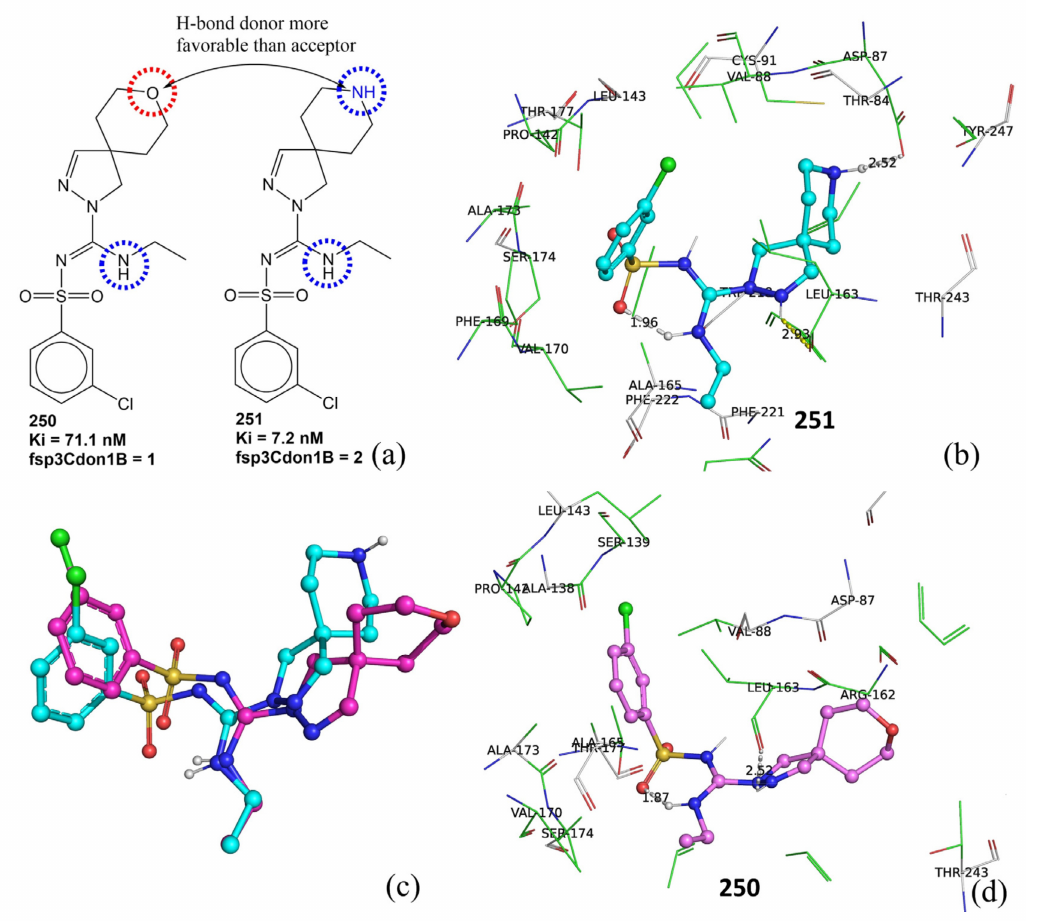
Figure 6. ( a ) Representation of fsp3Cdon1B using molecules number 250 and 251 as examples, ( b ) docking pose for molecule number 251 (dotted line represents H-bond formation), ( c ) overlap of docking pose of 250 (cyan) and 251 (pink), ( d ) docking pose for